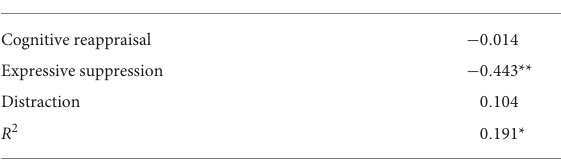
TABLE 2 Multiple regression analysis of the relationship between emotion regulation strategies and total